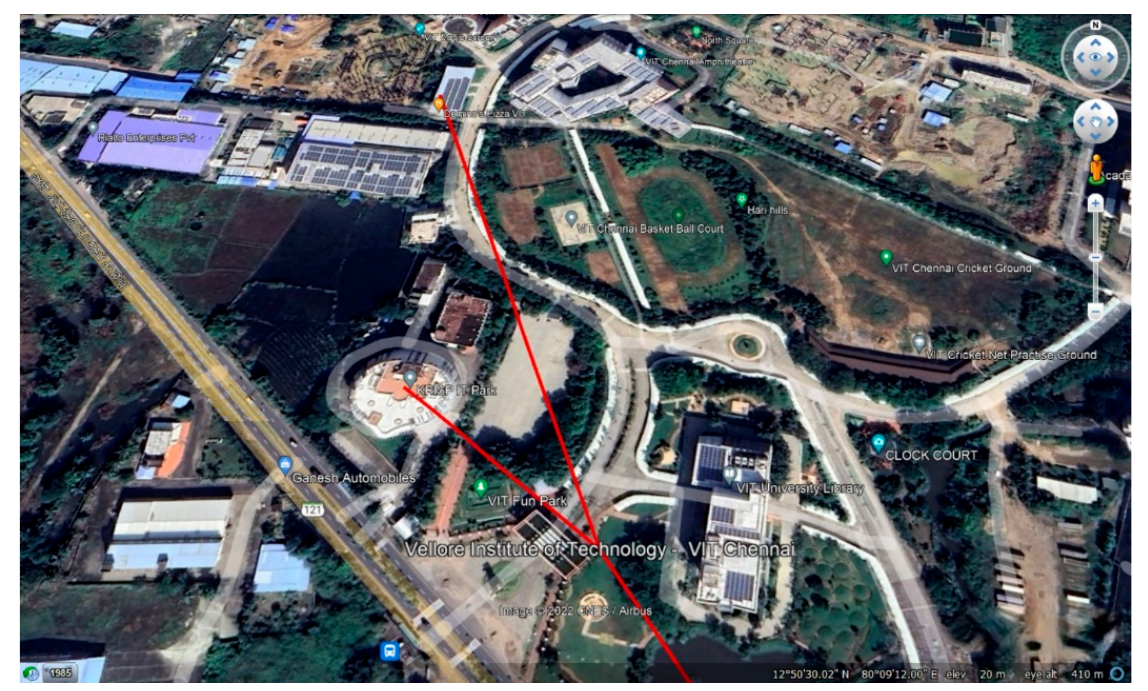
Figure 10. Detailed mapping of a user’s path for the contact tracing process .